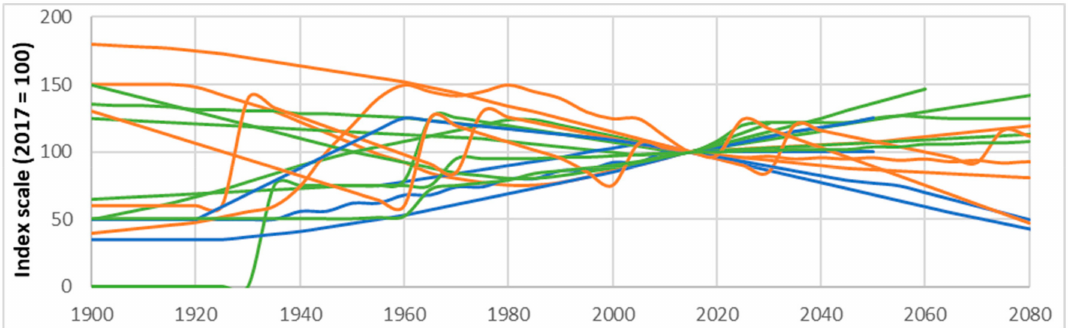
Figure 6. Trends of robustness over time, as perceived by participants, with y -axis as an index scale, 2017 = 100. Blue = robustness is a function of water supply, orange = robustness is a function of water supply a demand, green = robustness is a function of water supply, demand and economic and social dependency. Some lines do not cover the entire